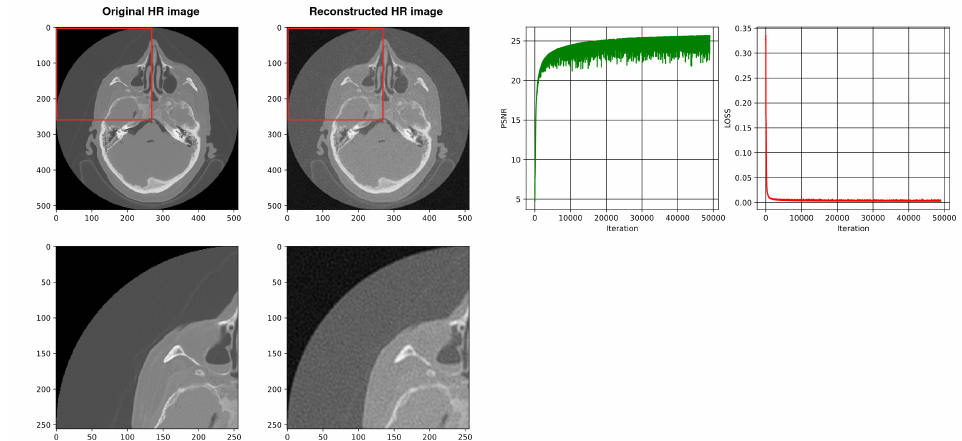
Figure 10. Shows the reconstruction of HR images using a two-layer SIREN without our architecture. The best PSNR is 25.26.